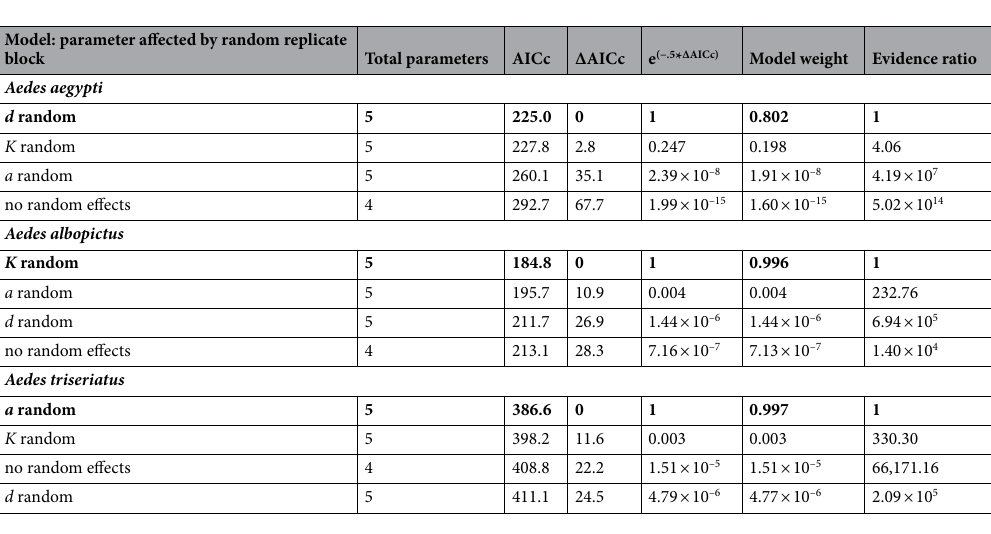
Table 2. AICc values comparing models of surviving adults S vs. initial density N for Aedes aegypti, Aedes albopictus, and Aedes triseriatus. Models that failed to converge excluded. For each species the best model is highlighted in bold face type. Within the table ΔAICc is the difference between AICc on the current line and AICc for the top line (i.e., the most plausible model).